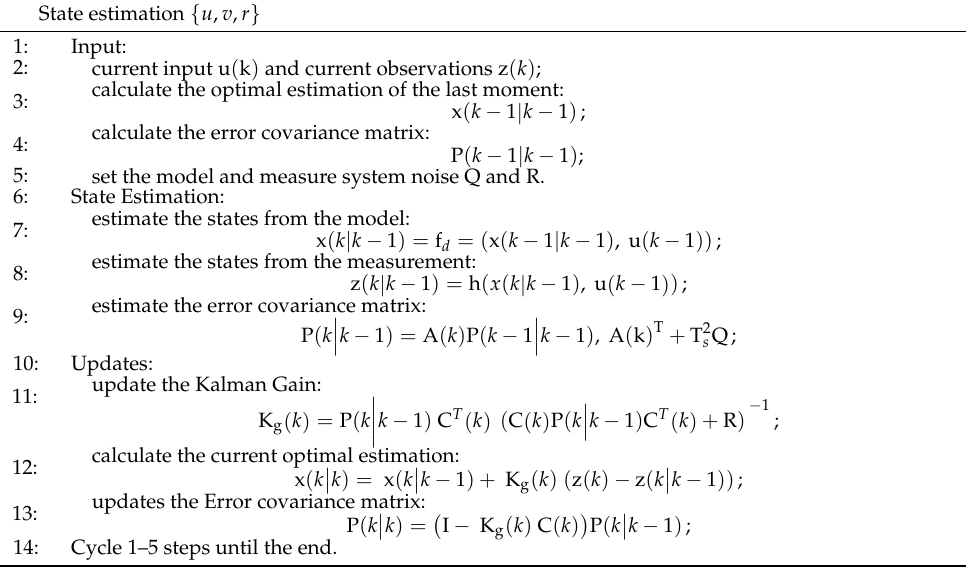
Table 1. The flow of EKF estimation. State estimation { u , v , r